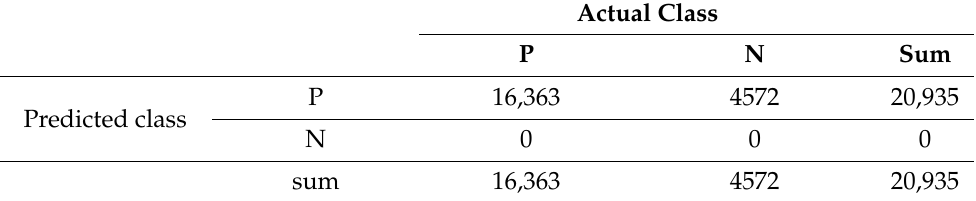
Table 3. Confusion matrix of SVM light